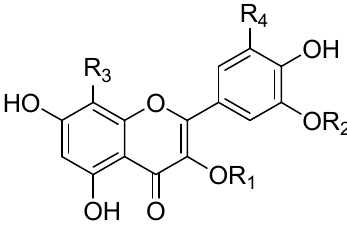
Figure 1. The structures of the seven flavonoids.